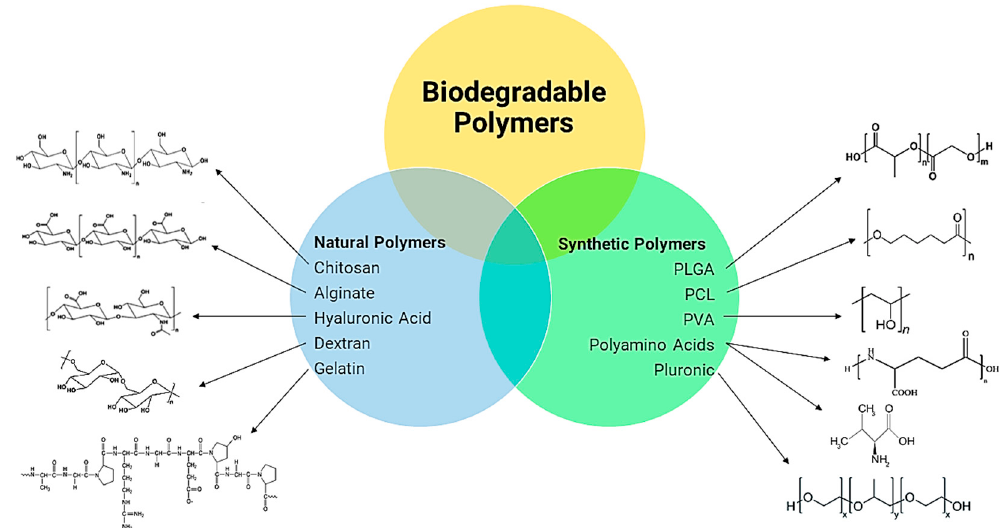
Figure 1. Biodegradable polymers employed in the delivery of nano-insulin formulations. Table 1. Summary of natural and synthetic polymers, their advantages, polymeric complexes, delivery systems, and alternative routes of administration employed in nano-insulin delivery. NPs: nanoparticles.